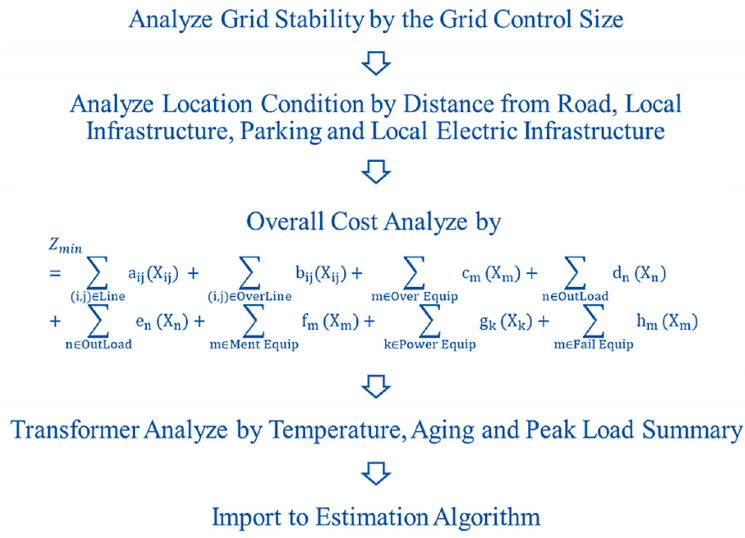
Figure 9. Hierarchy of algorithm input data.